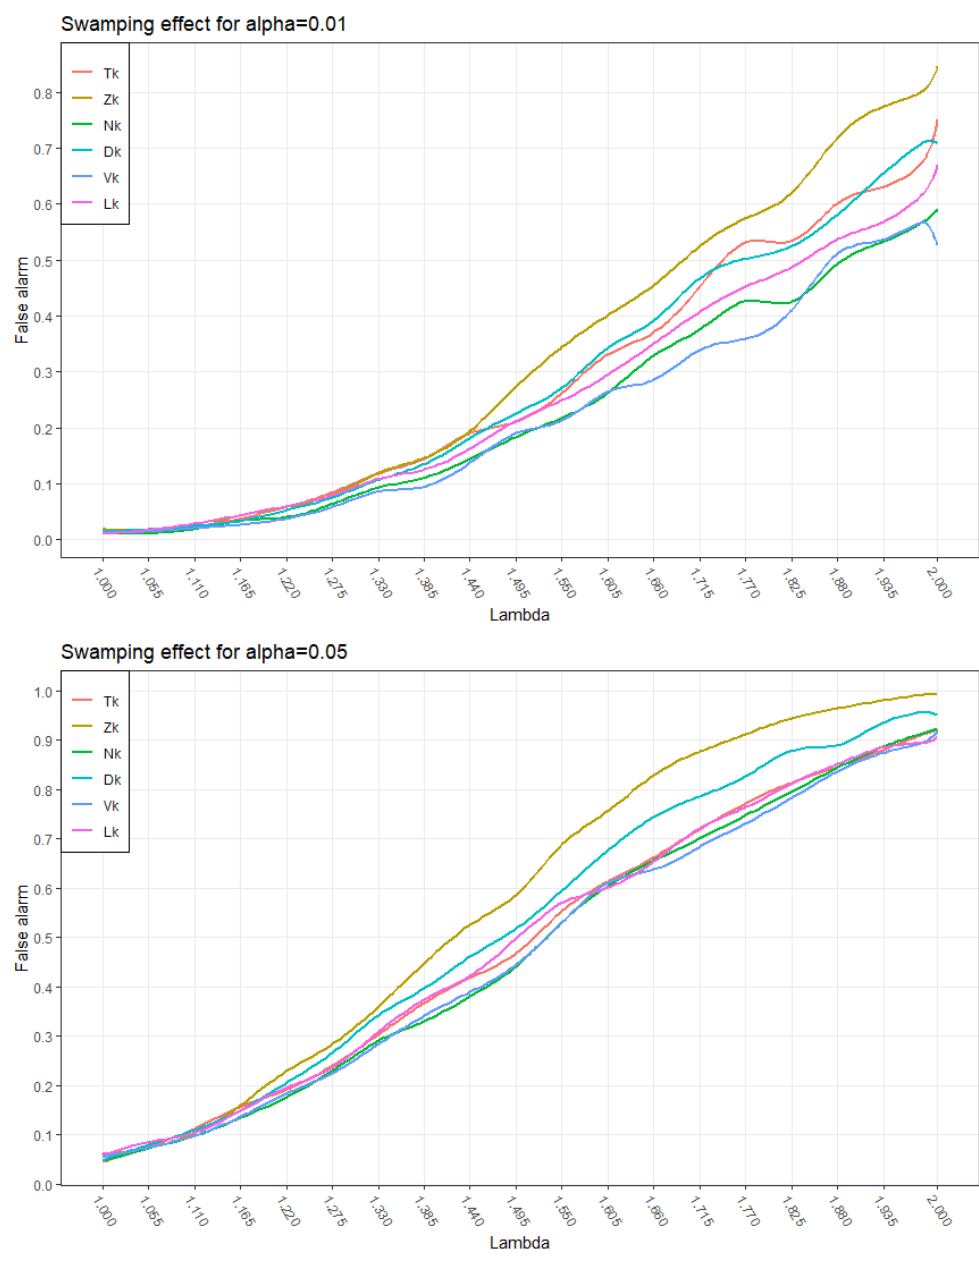
Figure 4. False alarm of statistics for m = 5, k = 5, k o = 2, and n =